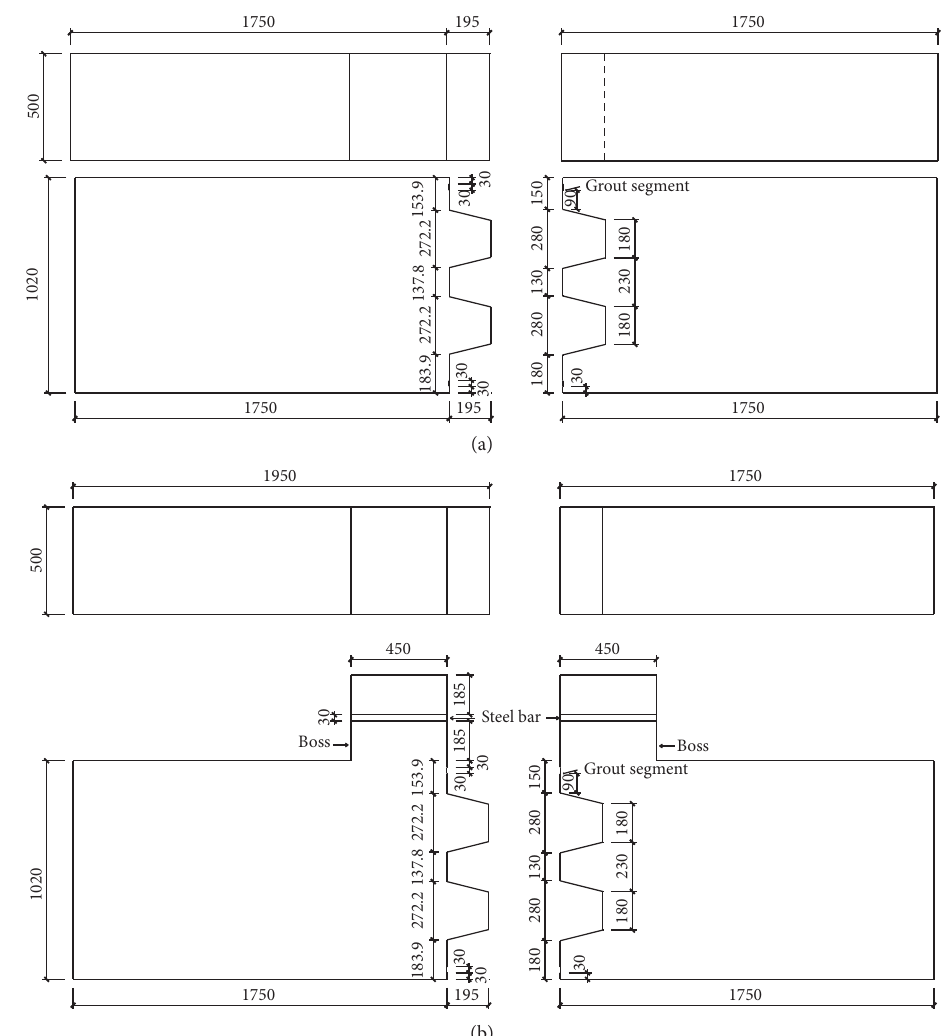
Figure 3: Specimens loading system layout: (a) without auxiliary pretightening device (unit: mm); (b) with auxiliary pretightening device (unit: